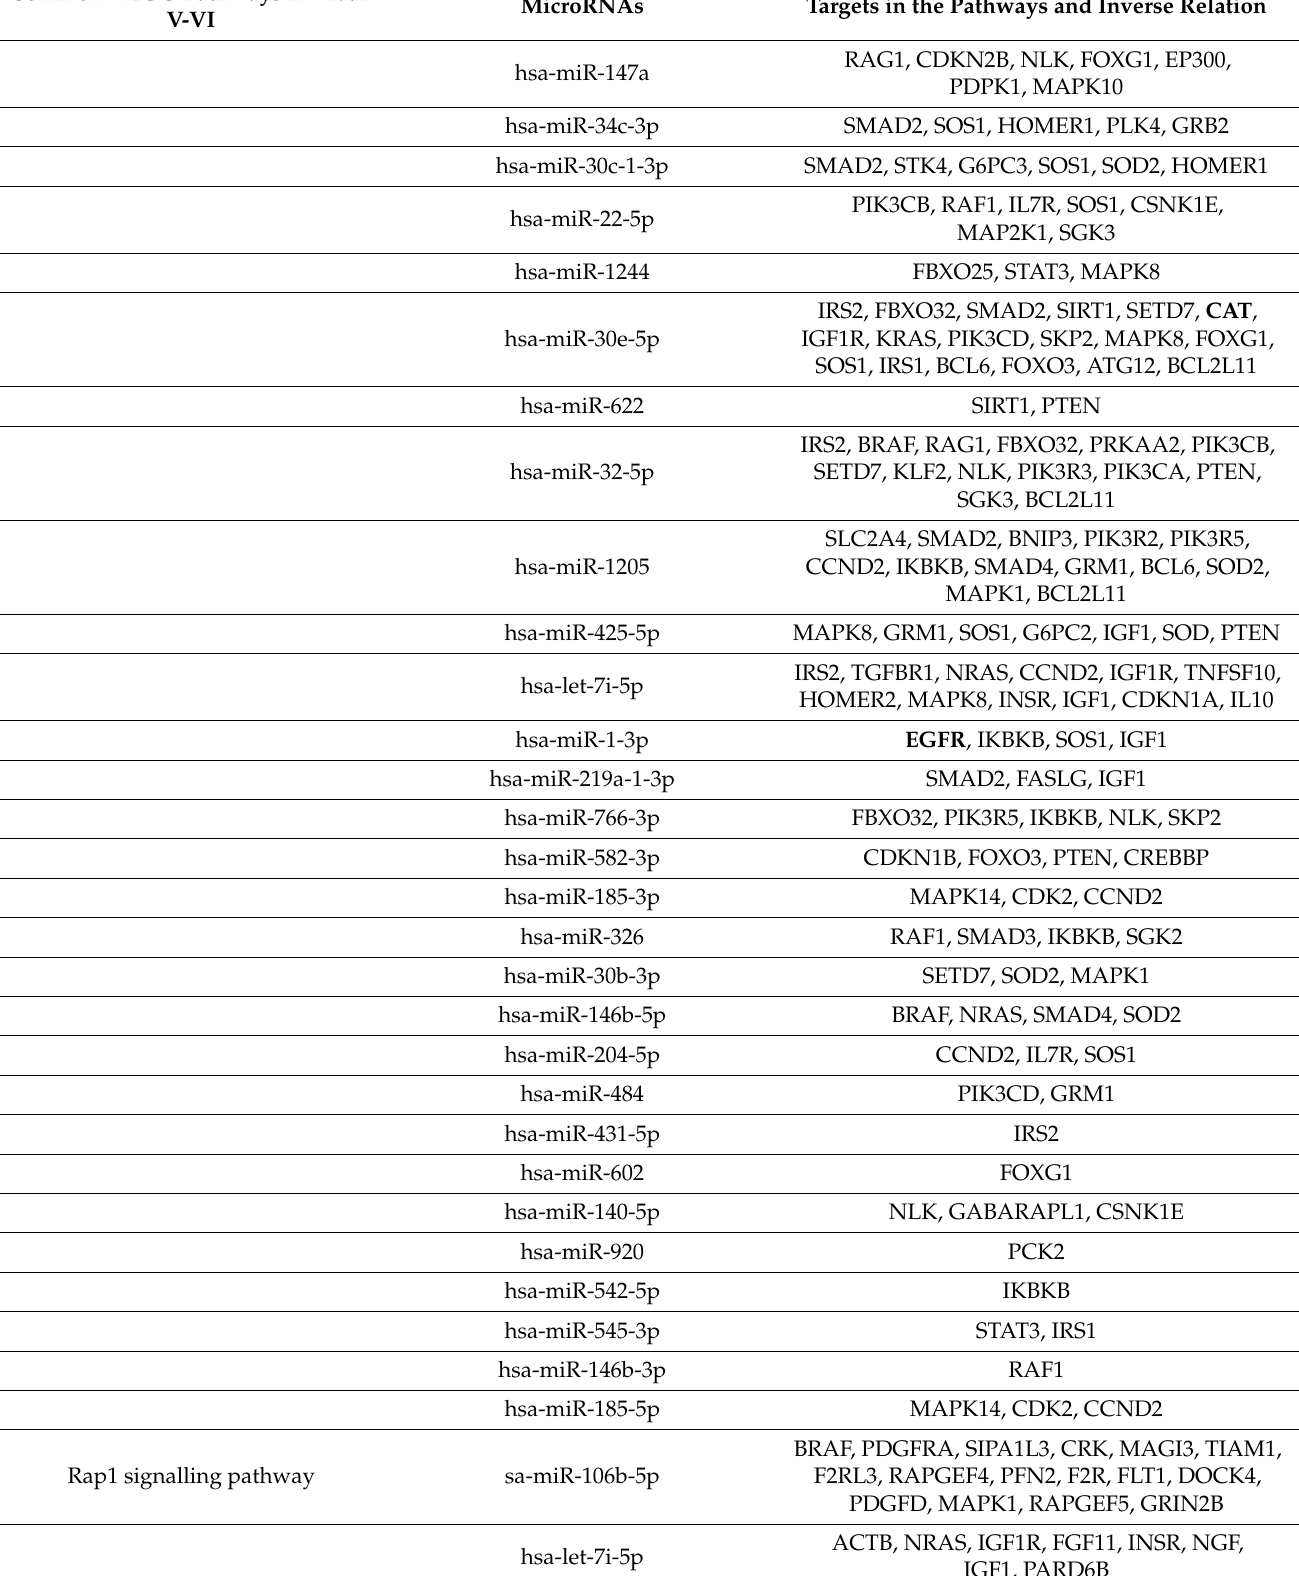
Common KEGG Pathways in